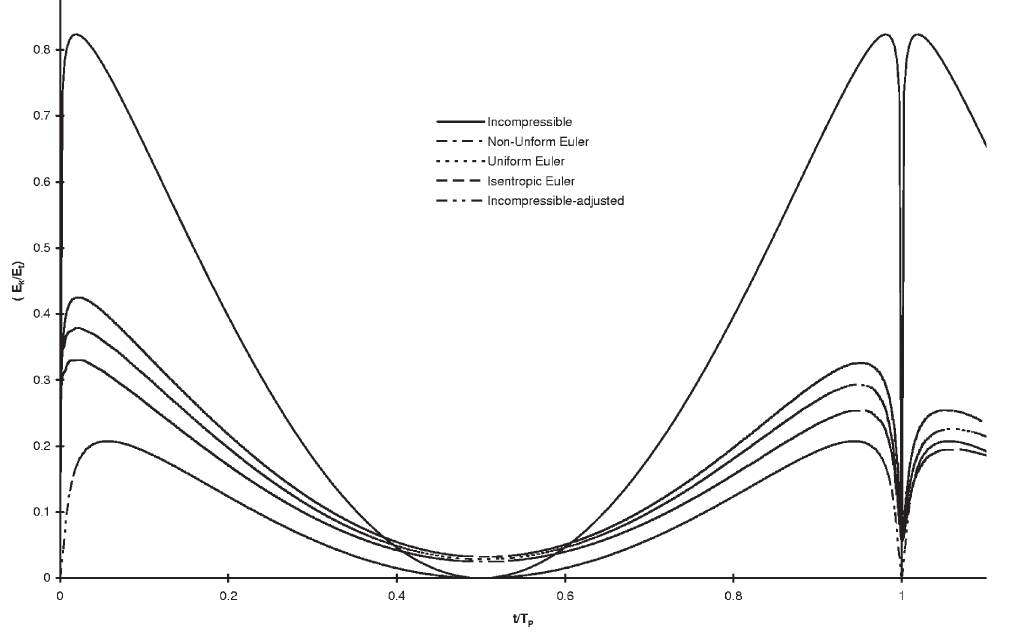
Fig. 10. Fraction of water energy converted to kinetic